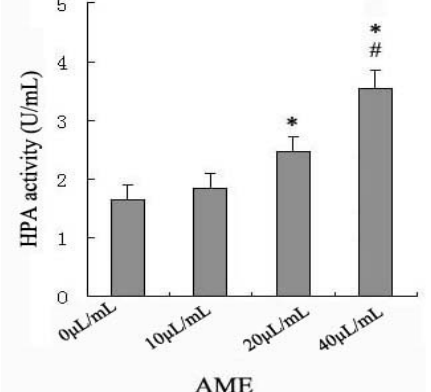
Figure 2. Effects of AME on the activities of HPA in Ana-1 macrophages. Cells (5 × 10 5 ) were incubated with AME (10–40 μ L/mL) respectively for 24 h at 37 °C. HPA activity was performed by using heparan degrading enzyme assay. * p < 0.05 significantly different from control (0 mg/L) and AME at 10 μ L/mL; # p < 0.05 significantly different from AME at 20 μ